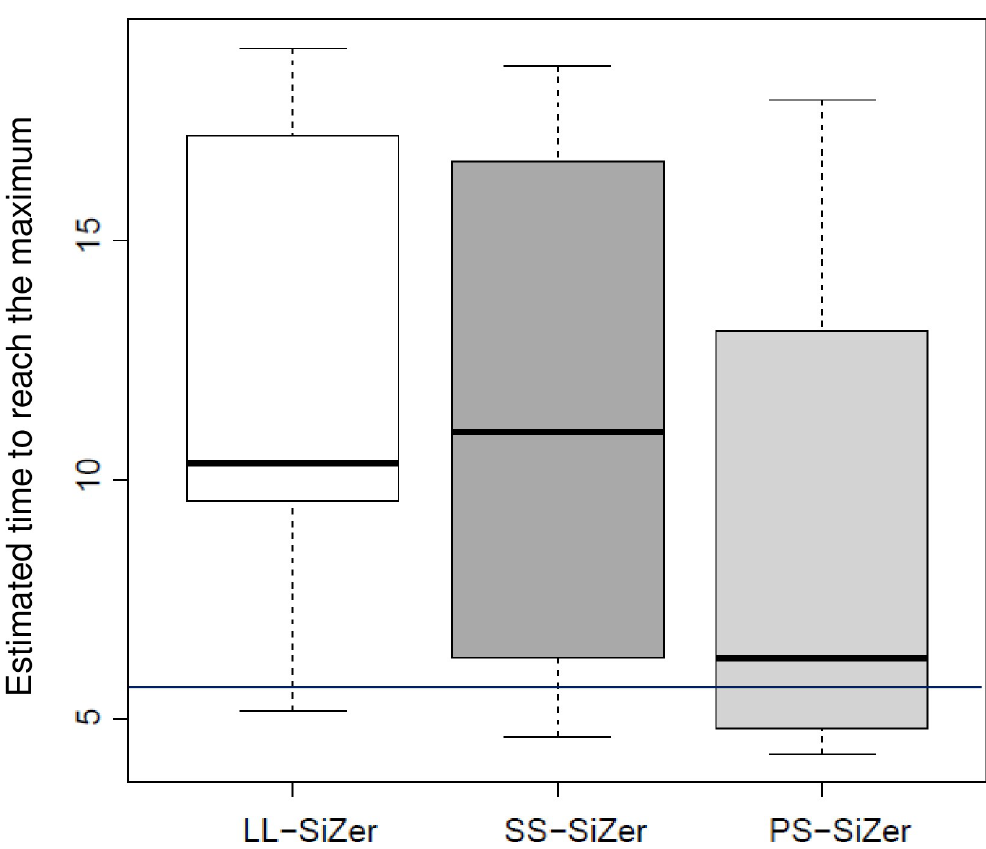
Fig 4. Boxplot-summary of three SiZer maps: Time to detect a true plateau in the data. https://doi.org/10.1371/journal.pone.0220165.g004 IeDEA region. Results from the remaining four regions are presented in less detail and are left for the supplementary material.